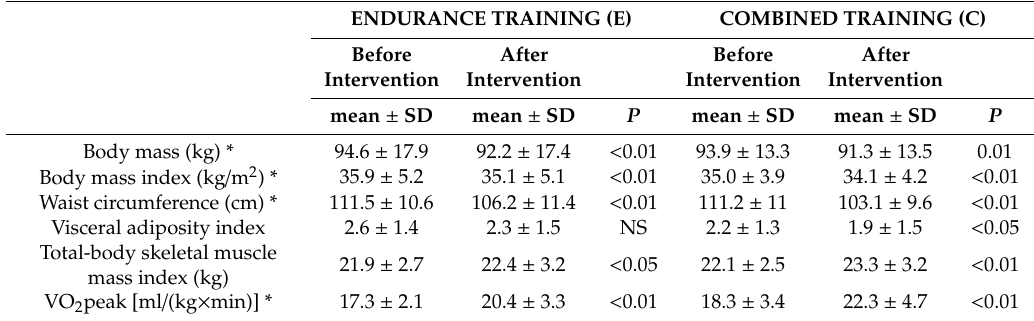
Table 1. Anthropometric parameters of E and C groups before and after a 3-month training programs.